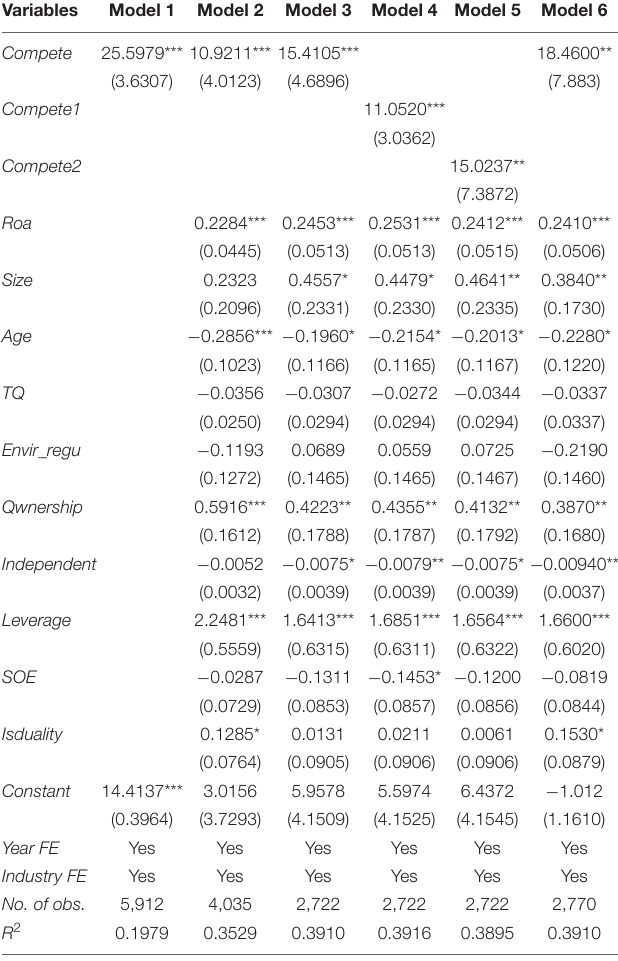
TABLE 2 | The impact of corporate competing culture on environmental